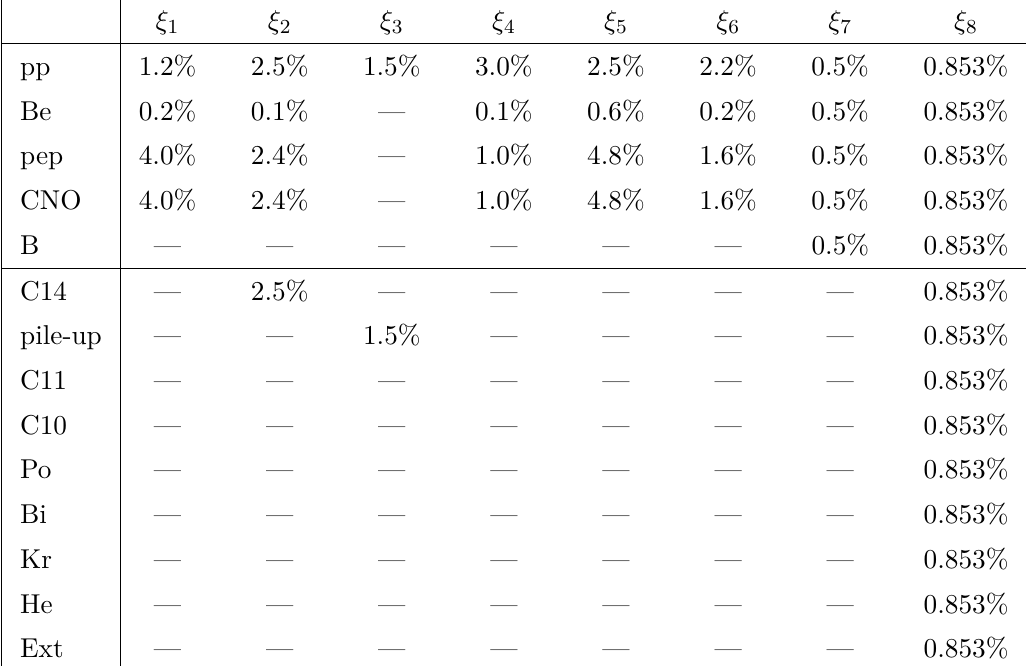
(upper part of the table) and Table 4 . Prior uncertainties assumed for each signal component σ r f for each background component σ r = σ r (lower part), for the eight nuisance parameters used c, tag c, sub to account for systematic uncertainties in the fit. Here, ξ correspond to the six first sources 1 − ξ 6 of systematic uncertainties listed in table IV of ref. [22] where they only show their effect on the determination of the solar fluxes in the Borexino fit. ξ corresponds to the choice of energy estimator 2 which we find to be also to be relevant for the determination of the steeply falling 14 C background. ξ 3 corresponds to the pile-up modelling so we assign similar uncertainties for the effect of that pull on the pile-up background. ξ corresponds to the combined uncertainty on the live time, scintillator 8 density and fiducial volume uncertainty from the same table which we assume affect all signals and backgrounds. ξ refers to an overall normalization error of the elastic scattering cross-section [36] 7 (which only affects the